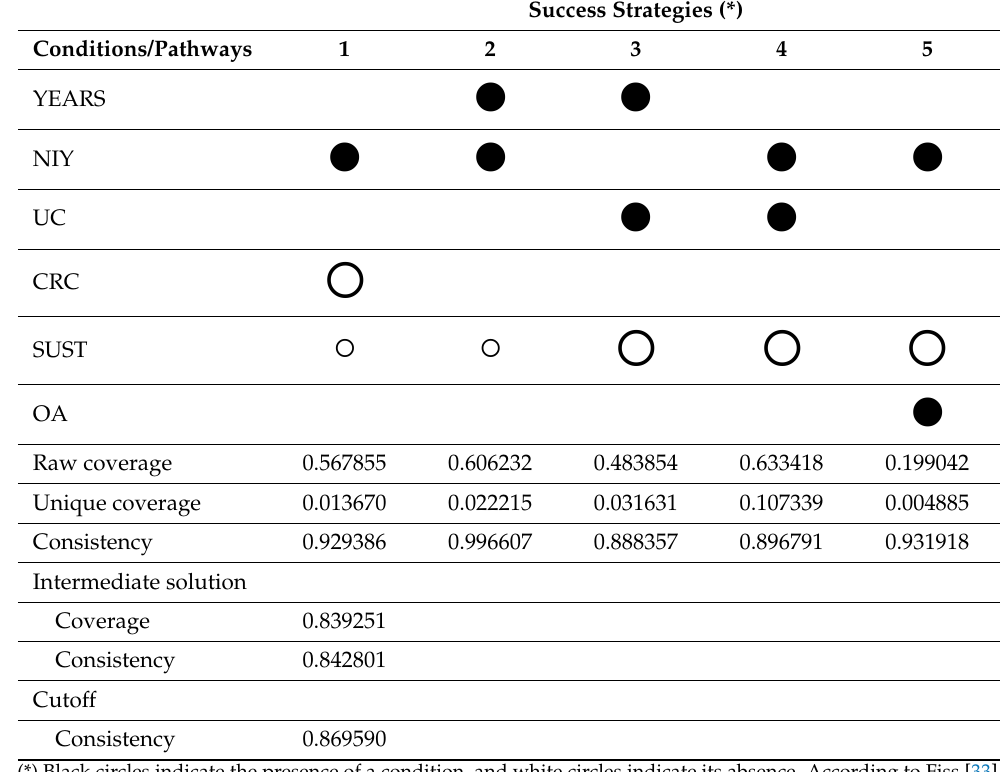
(*) Black circles indicate the presence of a condition, and white circles indicate its absence. According to Fiss [33], large circles indicate “core conditions”, small ones indicate peripheral conditions, and blank spaces indicate “don’t care”.